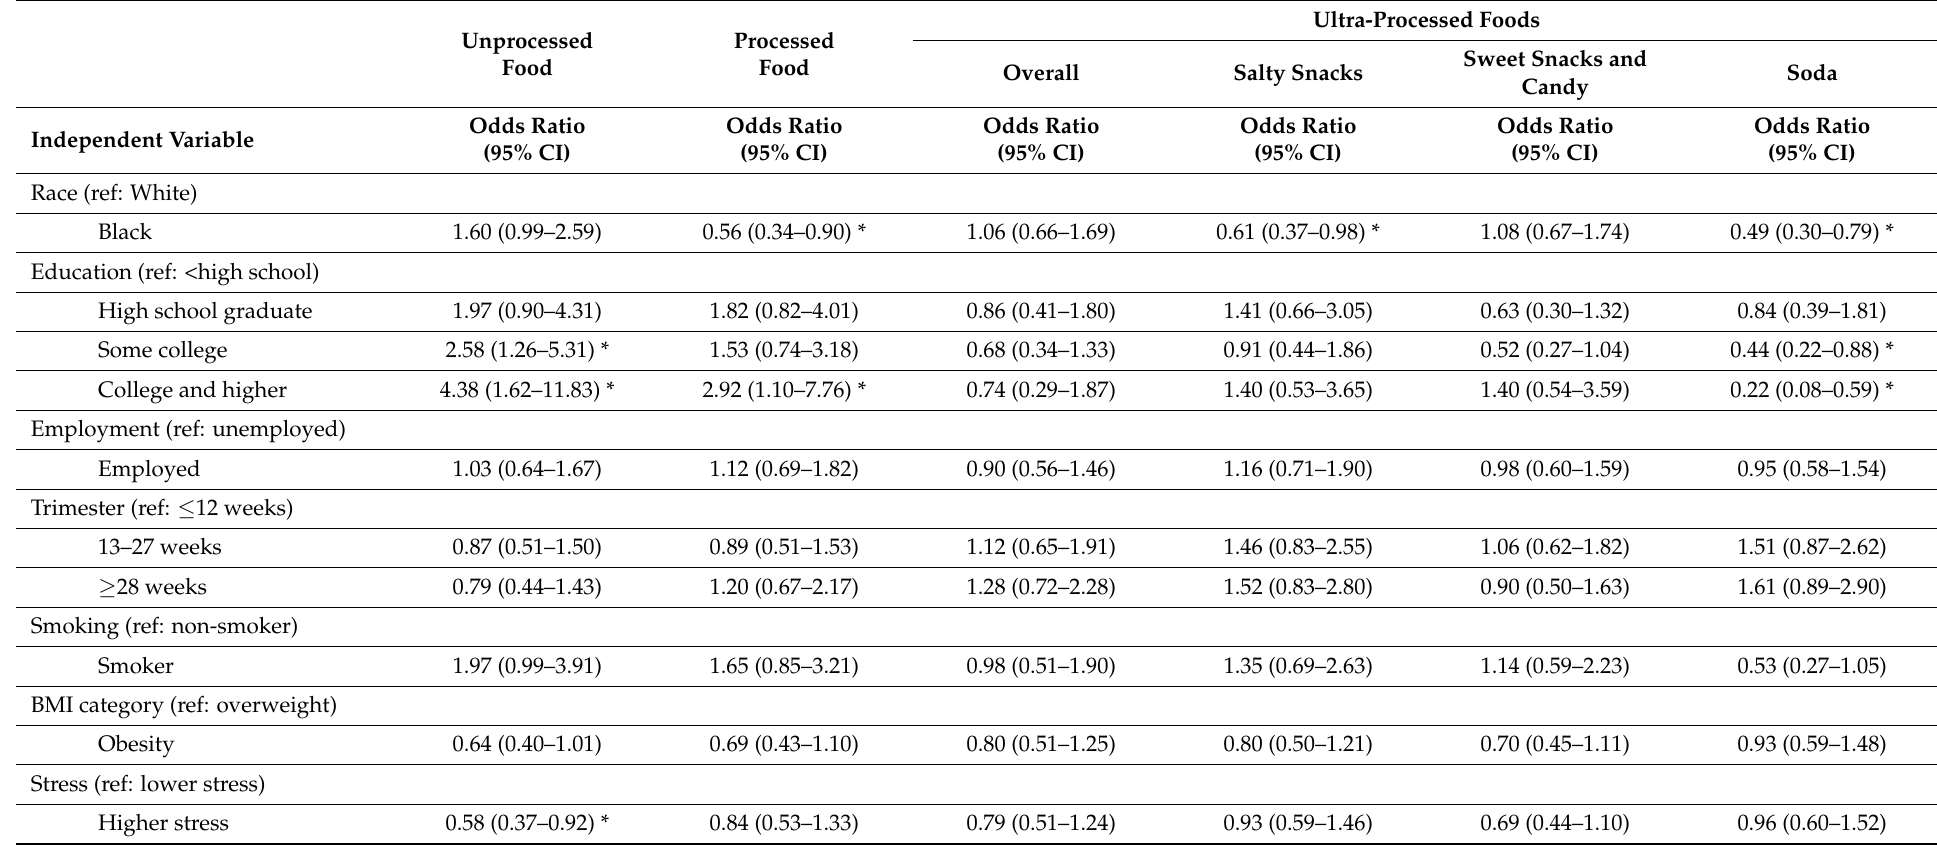
Table 3. Estimates of logistic regression by food items available at home (N =